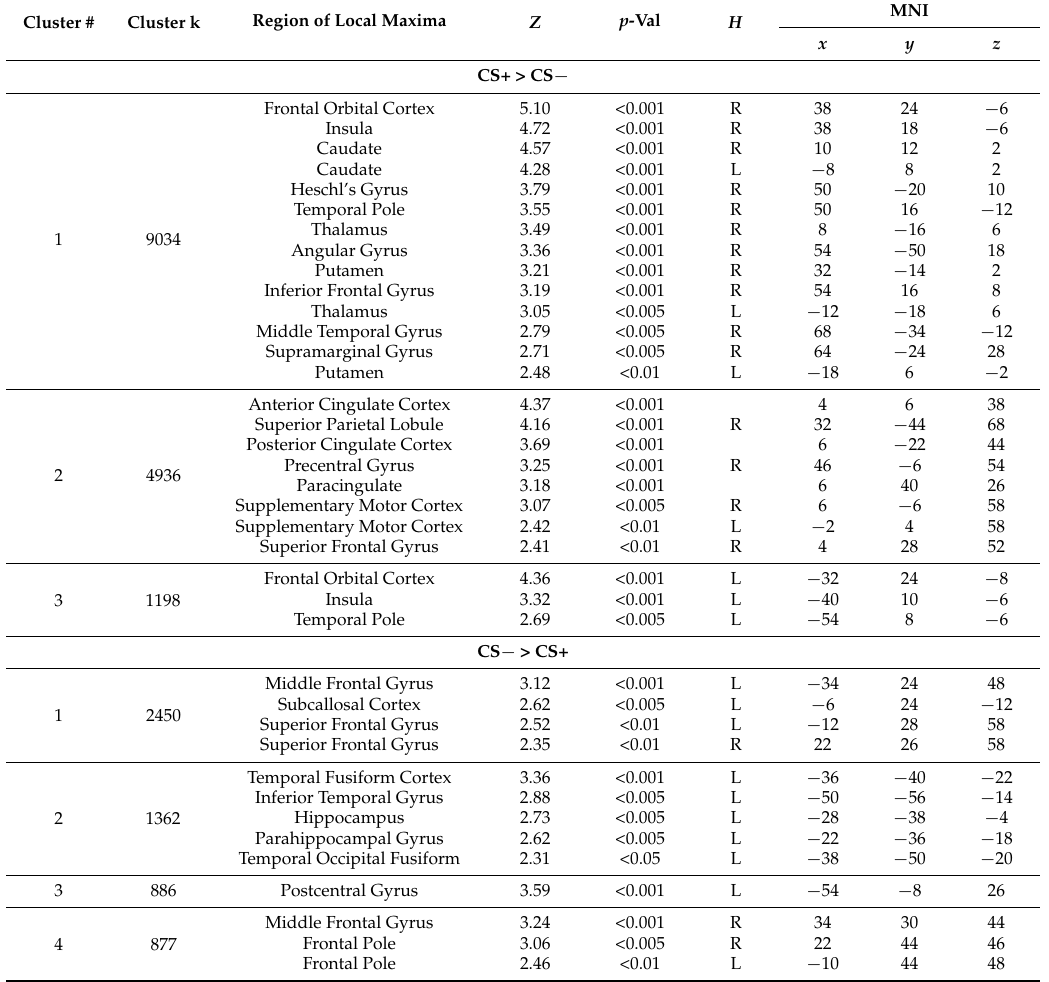
Table 2. Voxelwise analysis for tone only model with peak MNI coordinates. The regions of local maxima peak is derived from sub-regions within the larger cluster based on the Harvard-Oxford atlas in